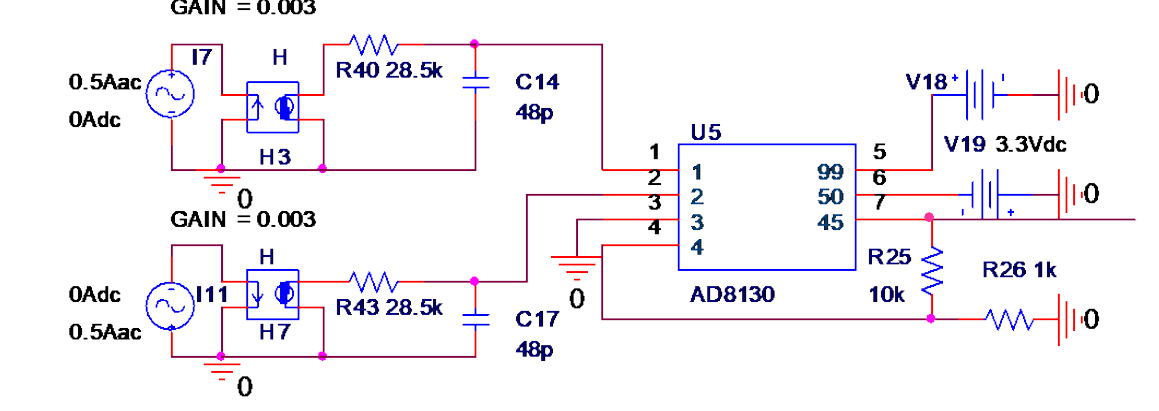
Figure 11. TMR low-frequency current sensor equivalent circuit simulation. As shown in Figure 12, the frequency characteristic curve of a single TMR low- frequency current sensor was obtained by simulation. The simulation results show that the − 3 dB bandwidth of the single TMR low-frequency current sensor was from DC to 116 kHz.